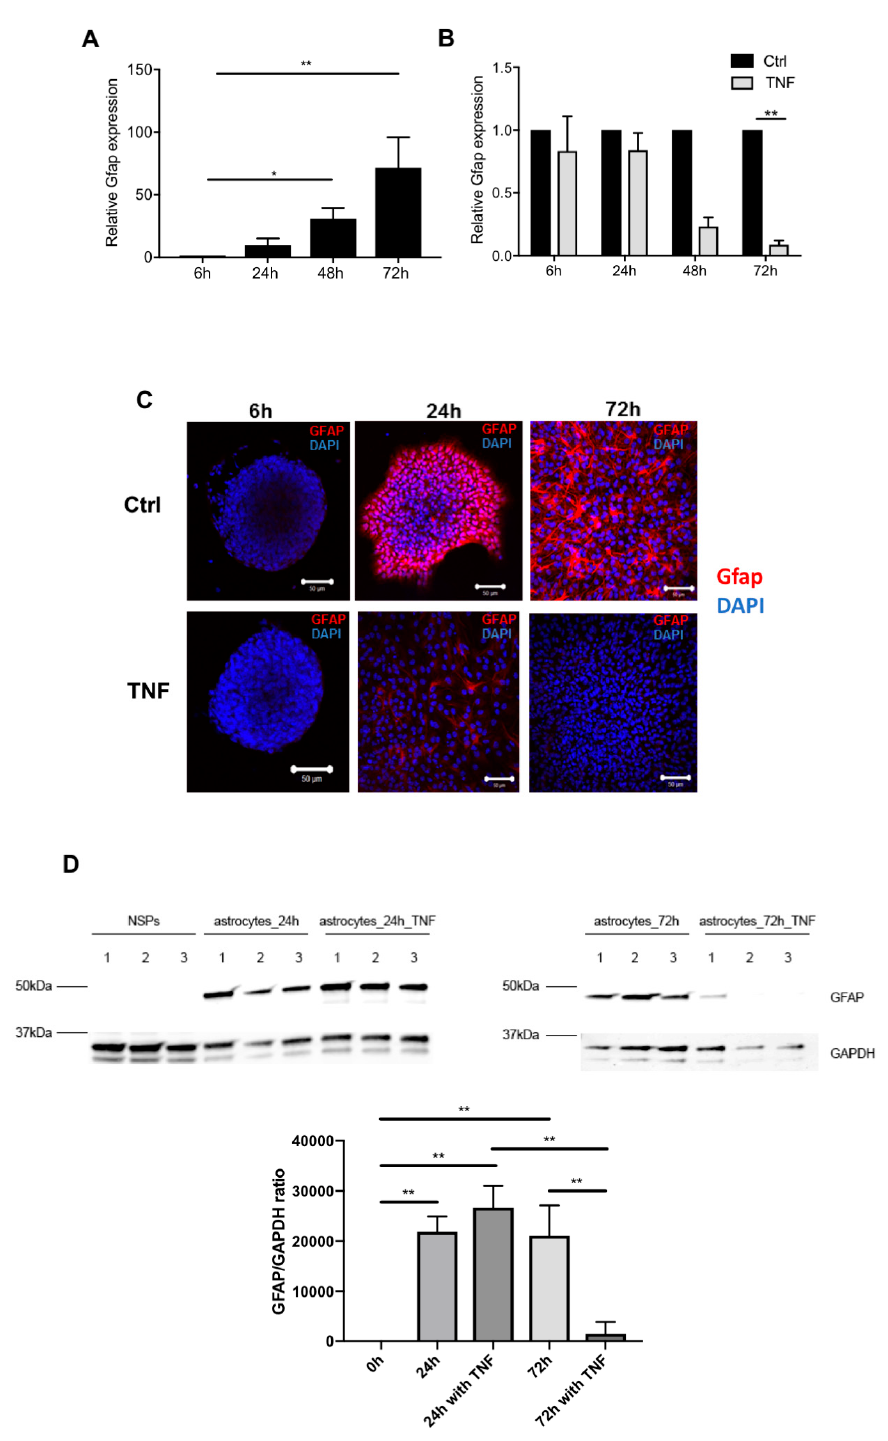
Figure 4. TNF modulates astrocytic differentiation through the classical Gfap marker. ( A ) Kinetic of Gfap mRNA gene expression obtained by RT-PCR. Each time point is normalized to its 6 h of differentiation. Results are given as mean ± SEM ( n = 3) * p < 0.05 and ** p < 0.01. ( B ) Effect of TNF treatment on Gfap gene expression obtained by RT-PCR. Each time point is normalized to its FBS control (Ctrl = 1) ** p < 0.01. Results are given as mean ± SEM ( n = 4). ( C ) Immunocytochemistry showing GFAP protein expression (red) in TNF treated cells at 6, 24, and 72 h. Nuclei were counter- stained by DAPI (blue). Scale bar: 50 µ m. ( D ) Immunoblots from TNF treated and untreated at 0, 24, and 72 h of differentiation. GFAP protein expression is affected by TNF, ** p <